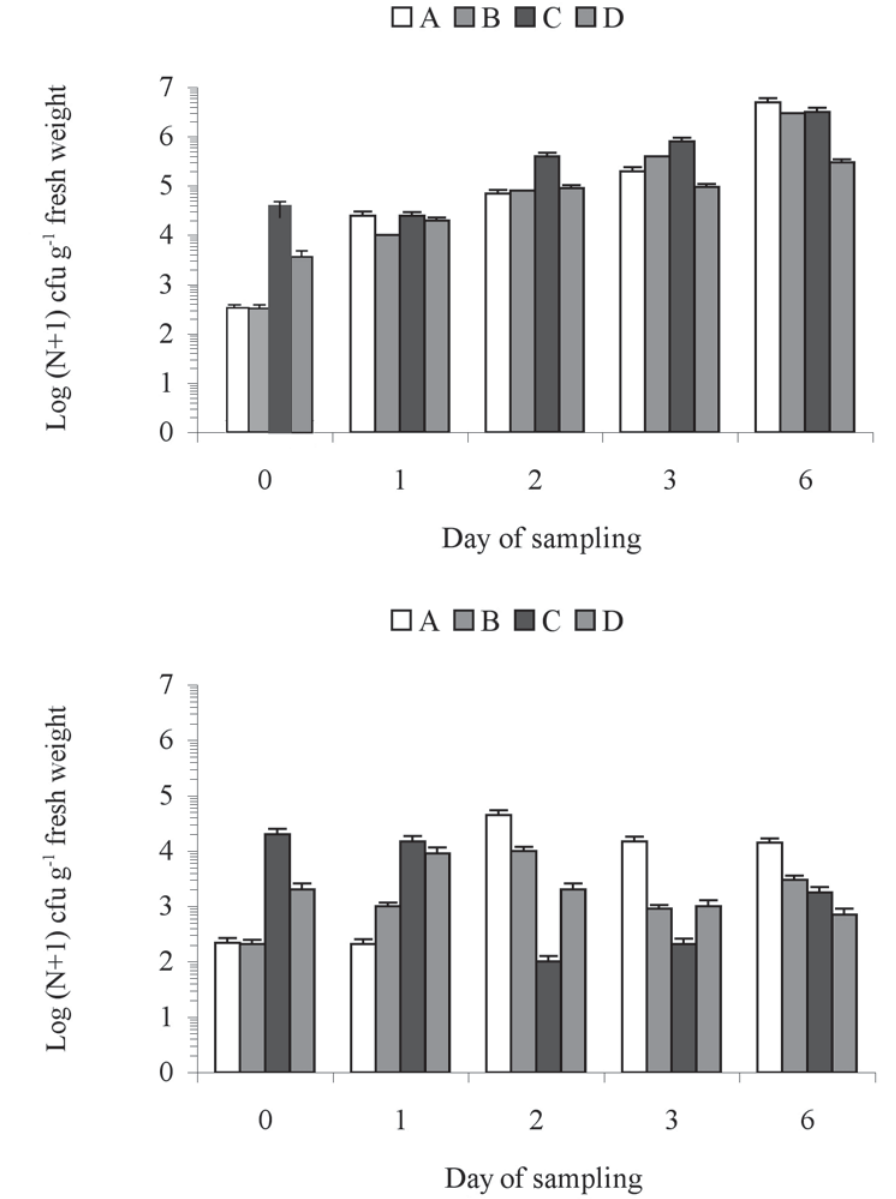
Fig. 2. Endophytic bacterial populations in various gerbera scape portions (see the legend in Fig. 1) using tap water (upper) and AgNO solutions (lower). Data represent the means (±SD) of 10 3